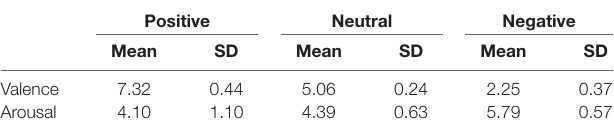
TABLE 1 | Rating scores for affective image